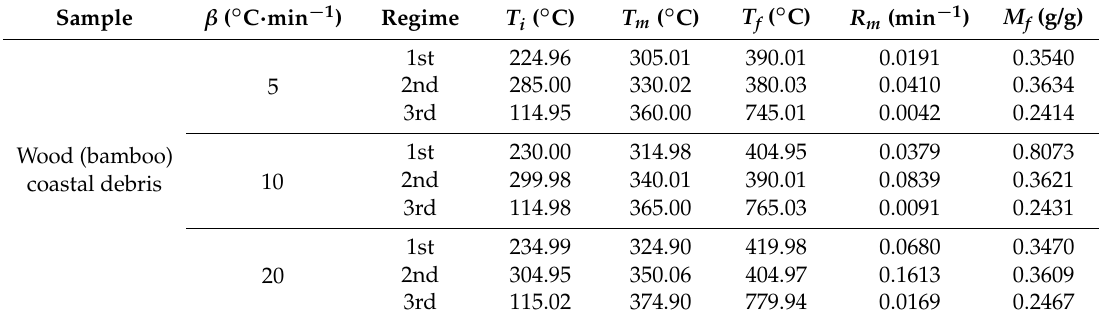
Table 3. Characteristics of the wood coastal debris sample in the pyrolysis